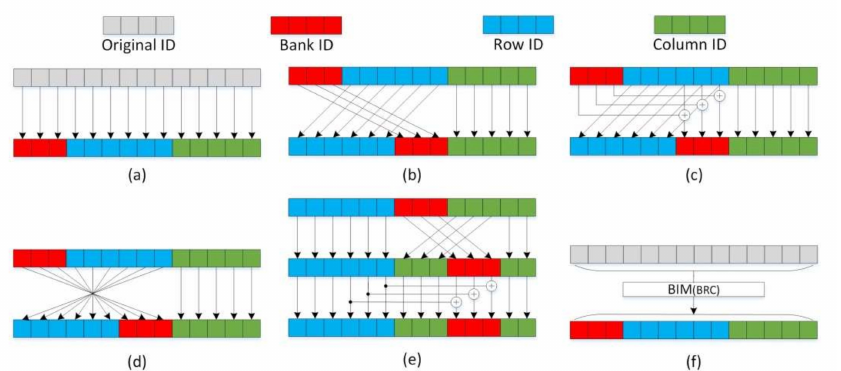
Figure 2. Different address mapping schemes. ( a ) Bank – Row – Column. ( b ) Row – Bank – Column. ( c ) Permutation – Based Page Interleaving. ( d ) Bit – reversal. ( e ) Minimalist open – page. ( f ) Binary Invertible